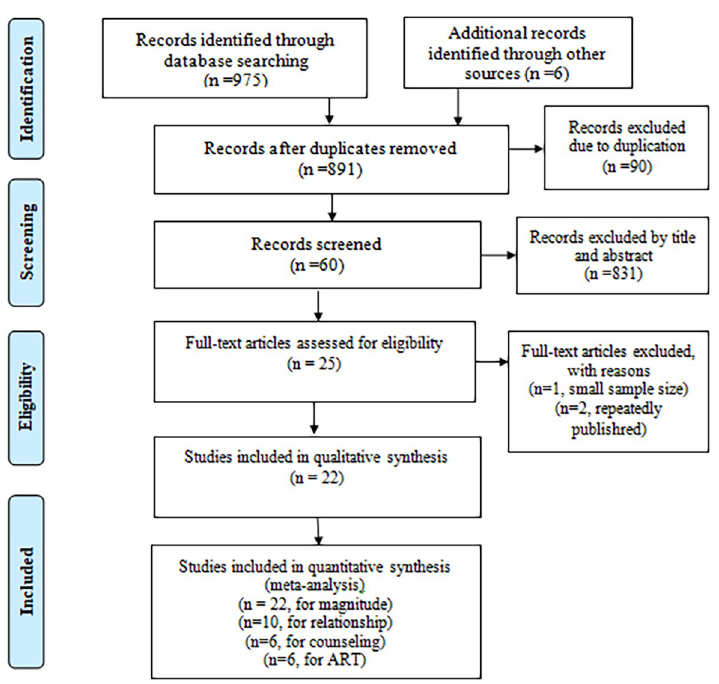
Fig 1. PRISMA flow diagram of determinants of disclosing HIV positive status to sexual partner among adult HIV patients in Ethiopia, 2020.